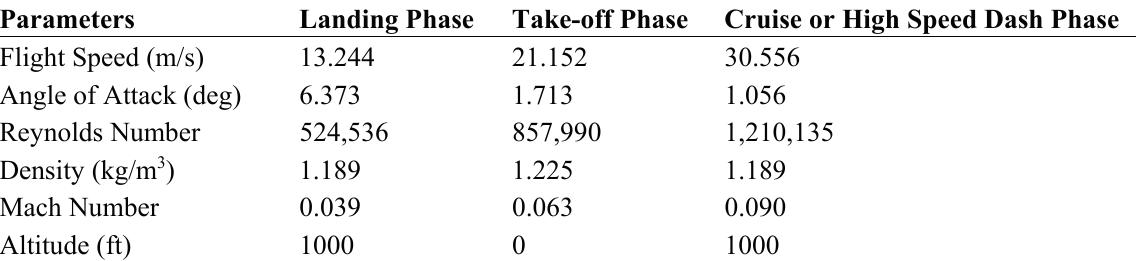
Table 8. Summary of flight parameter used in the CFD